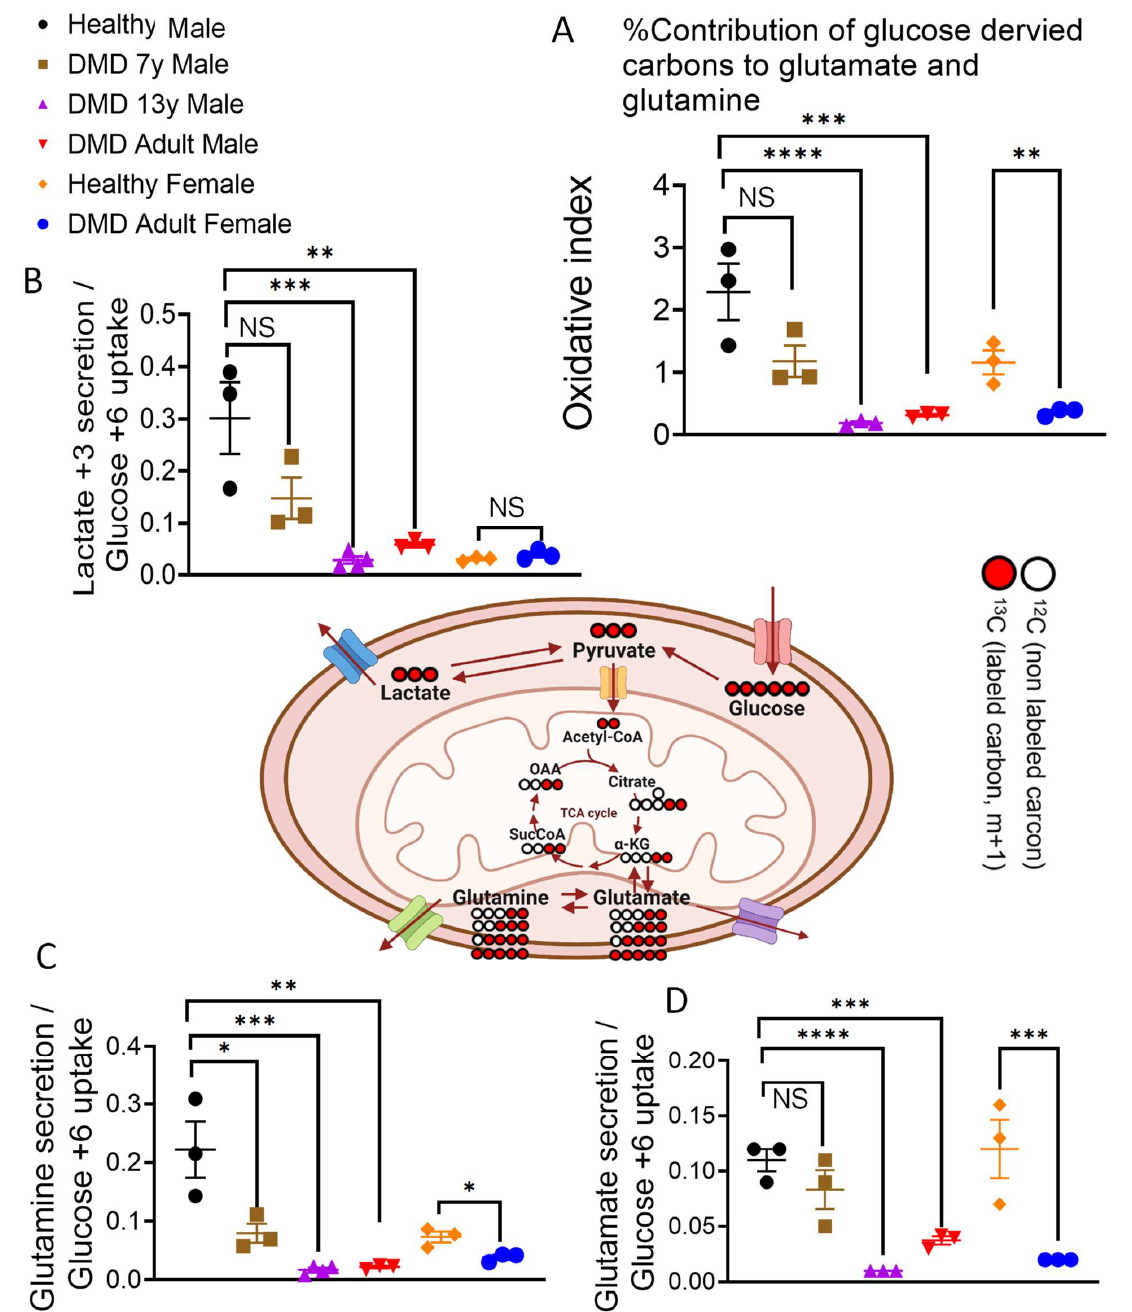
Figure 3. Glucose tracing in DMD iPSC-CMs. LC-MS measurements of labeling pattern for glycolytic and TCA cycle derivatives indicated as lactate ( B ), glutamate ( D ), and glutamine ( C ) secretion following 24 hours incubation with 13 C 6 -labeled glucose. Labeling patterns of glucose derived carbons are detailed in the middle scheme. DMD adult male, adult female and the 13-year-old (13y) CMs showed a decrease in oxidative metabolism compared to healthy and the DMD 7-year-old (7y) CMs. Oxidative index ( A ) is calculated as the ratio between the weighted sum of 13 C-glucose-derived secreted glutamate ( B ) and glutamine ( C ) to the uptake of 13 C 6 -glucose. The Shapiro–Wilk test of normality was applied for all metabolites to assess whether the data were normally distributed. Two tailed homoscedastic t-test over log-transformed data; NS = non-significant, * p < 0.05, ** p < 0.01, *** p < 0.001, **** p < 0.0001.